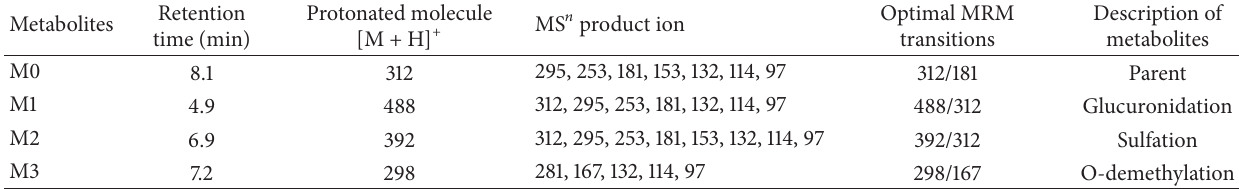
Table 2: Mass spectra data and proposed structures of leonurine metabolites in